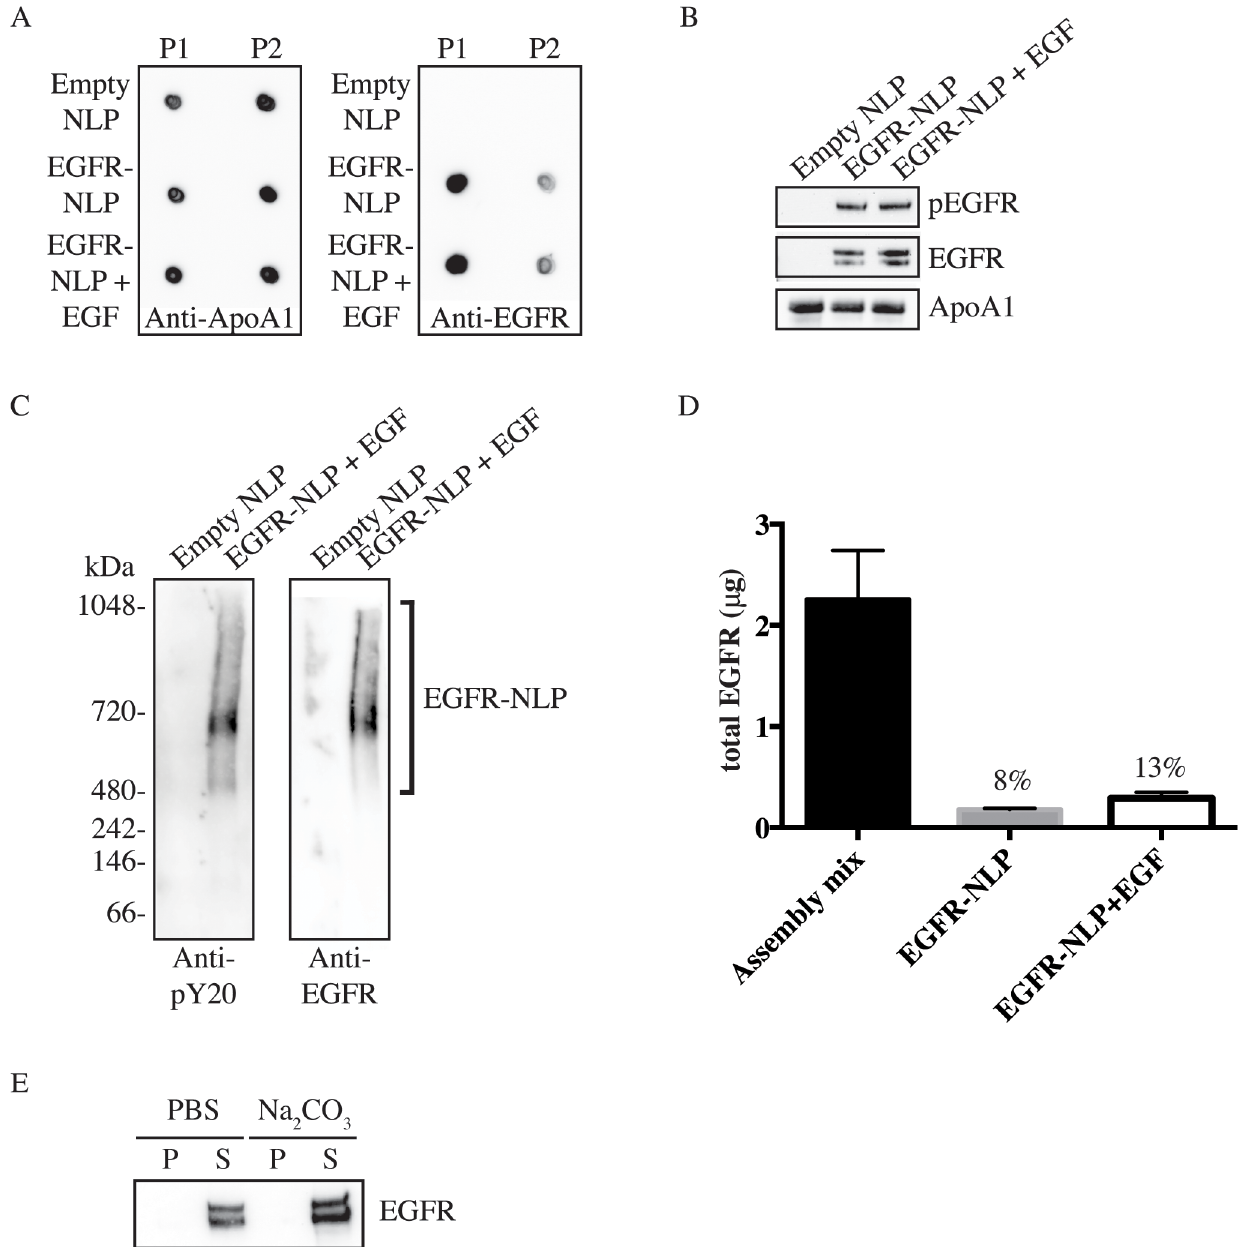
Fig 3. EGFR incorporation in self-assembled NLPs. A , P1 and P2 SEC fractions were collectedand spotted onto nitrocellulose membrane followedby immunoblotting with anti-ApoA1 and anti-EGFR antibodiesshowingthat the majority of EGFR is incorporatedinto the higher molecularweight NLPs of the P1 fraction. B , IndicatedNLPs were separatedby denaturingSDS-PAGE and analyzedwith anti-pEGFR, anti- EGFR, and anti-ApoA1 antibodies.Numbers indicate bandintensity relative to EGFR-NLP normalized to ApoA1 signal. C , Purified Empty and EGFR-NLPs were separatedby NativePAGE gels and immunostained with anti-pY20and anti-EGFR antibodiesshowingEGFR expressionin the highermolecularweight ranges above 480 kDa. D , Bar graph of determination of EGFR insertioninto NLP. Total amount of EGFR in the NLP assembly mixture and purifiedEGFR-NLPs were determined by ELISA and EGFR insertion rate indicated.The values represent the mean ± standarderror of the mean (SEM) for two technicalreplicates. E , EGFR-NLPs were extracted with PBS (control) or sodium carbonate (Na 2 CO 3 ), centrifugedto separatethe supernatant containingNLPs (S) and pellet containing insolublefree protein (P), separatedby denaturing SDS-PAGE, and analyzedwith anti-EGFR antibody showingthat EGFR is not susceptible to carbonateextraction.